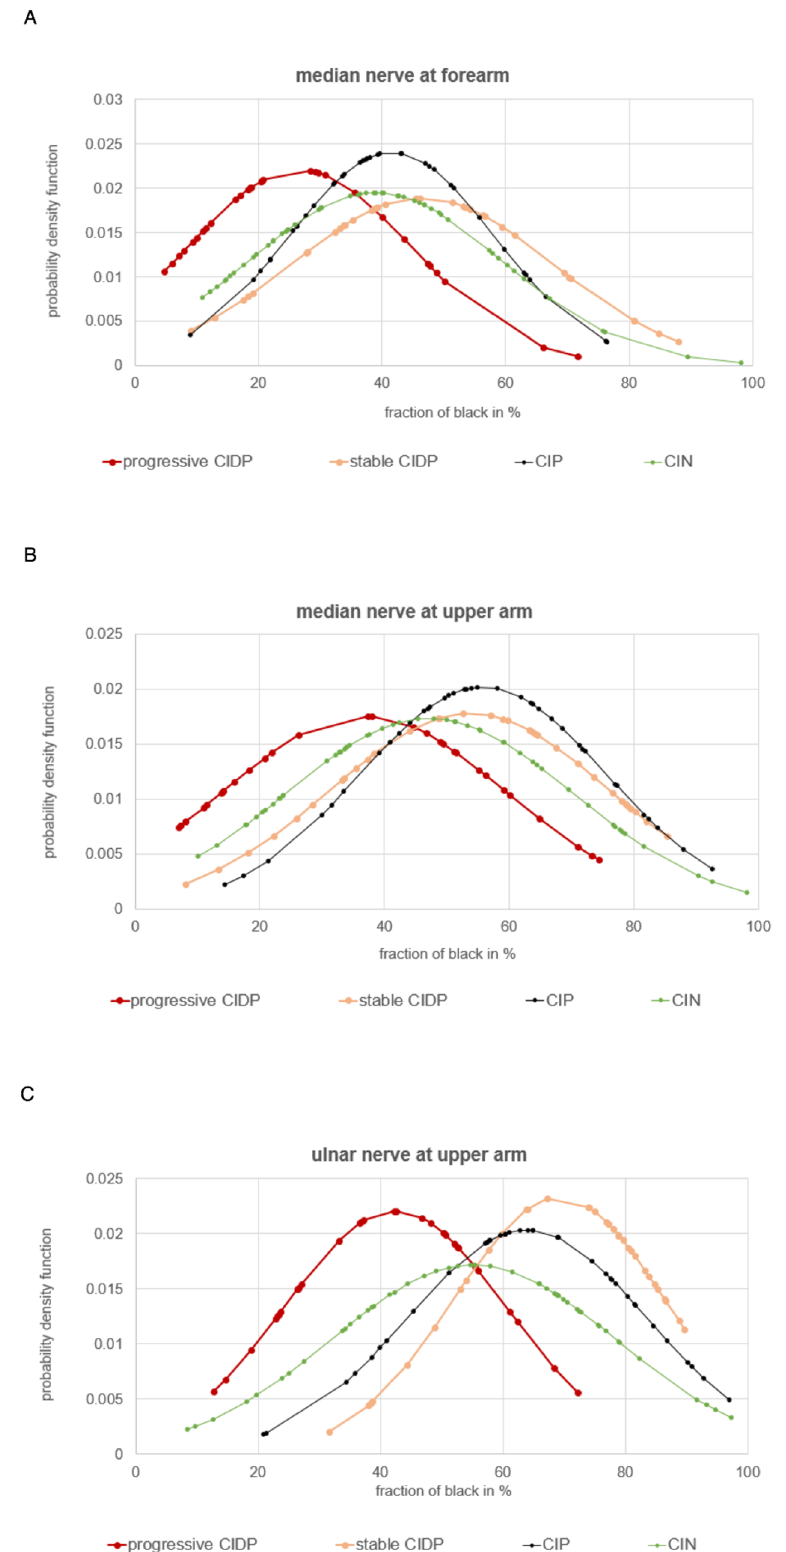
Figure 3. Distribution of echogenicity of the significant examination sites of patients with CIDP (progressive disease course = red, n = 8 and stable/regressive disease course = orange, n = 12) in comparison to patients with CIP (black, n = 19) and CIN (green, n = 27). ( A ): median nerve in forearm, ( B ): median nerve in upper arm, ( C ): ulnar nerve in upper arm.